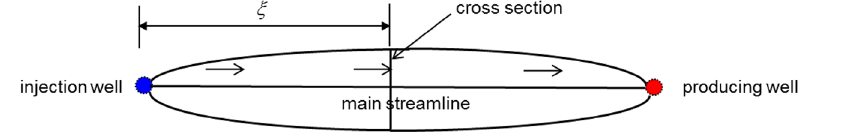
Fig. 2 Single flow tube sketch diagram